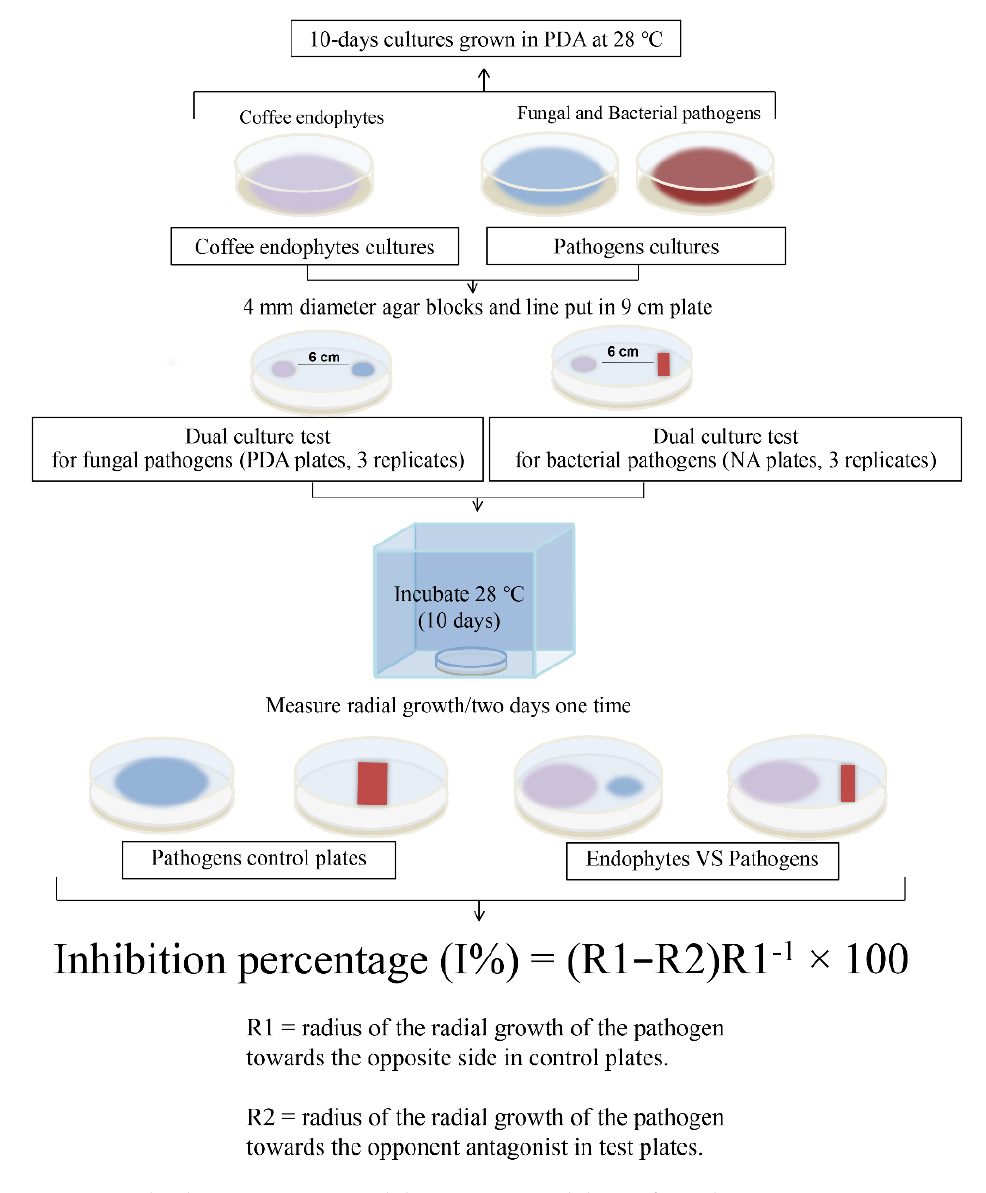
Figure 2. Dual-culture assay steps and the percentage inhibition formula. Table 3. Information of the pathogens obtained from CGMCC.